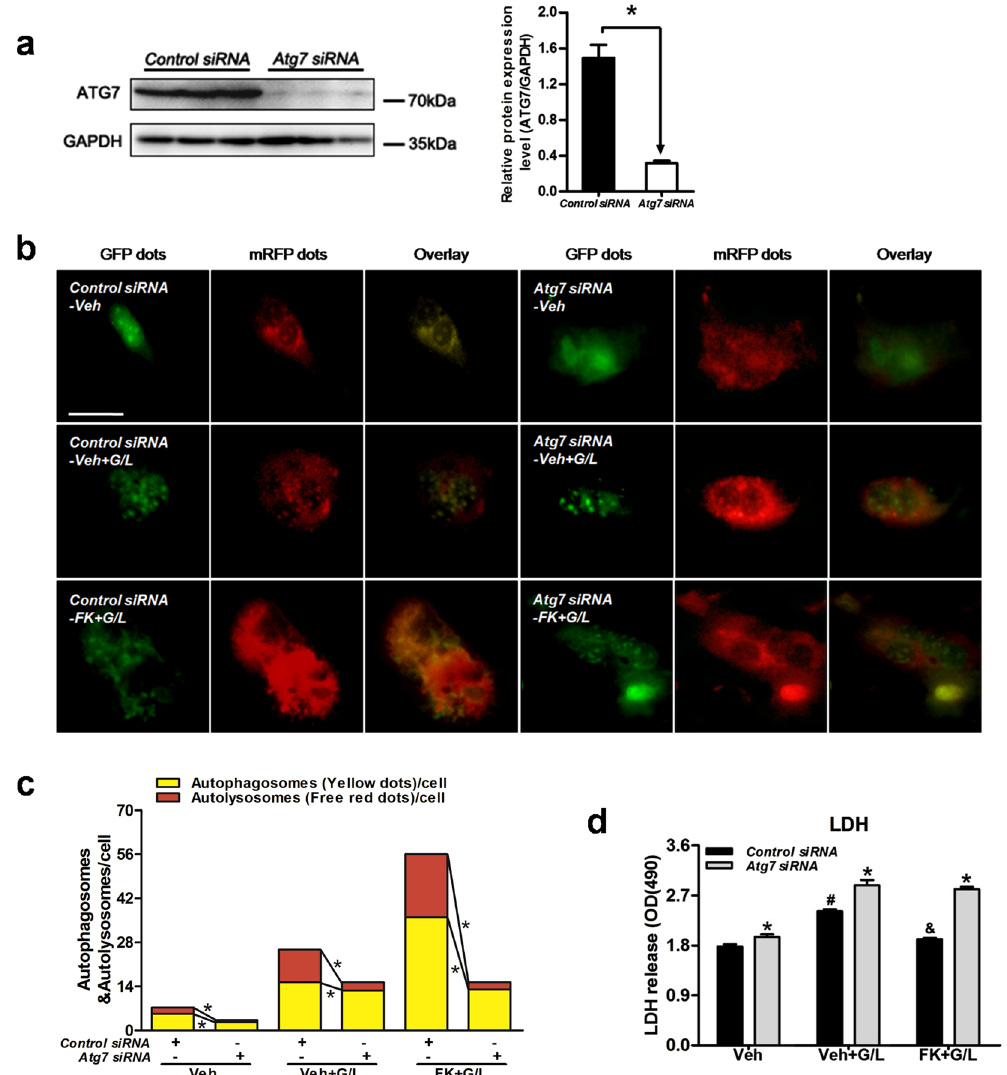
Figure 6. Knockdown of Atg7 abolishes FK866-conferred hepatoprotection in vitro . Hepatocytes were treated with either Control siRNA or Atg7 siRNA (50 nmol/L, 48 h) prior to FK866 treatment (FK, 100 nmol/L, 30 min) and followed by GaIN/LPS (G/L, 1 /mg/mL /30 ng/mL, 24 h) challenge. ( a ) ATG7 protein expression was examined by western blot analysis. The data are shown as the means ± SEM of three independent experiments performed in duplicate. * P < 0.05 indicates significant differences. ( b ) Representative fluorescence micrographs showed autophagy vacuoles in hepatocytes with or without Atg7 siRNA from a pool of at least 10 images. Original magnification × 200, scale bar 50 µ m. ( c ) Quantification of autophagosomes and autolysosomes. * P < 0.05. ( d ) Determination of LDH release of primary hepatocytes. The data are shown as the means ± SEM of three independent experiments. * P < 0.05 vs. the corresponding Control siRNA groups, # P < 0.05 vs. the corresponding vehicle (Veh) groups, & P < 0.05 vs. the corresponding Veh + G/L